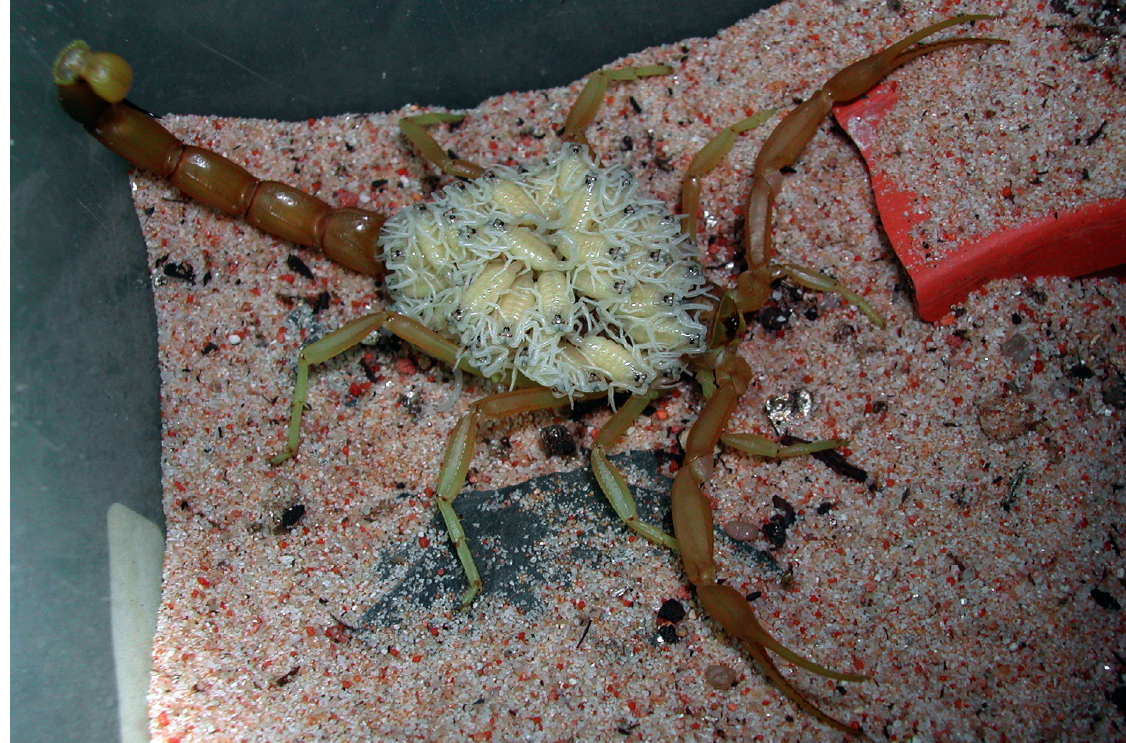
Figure 2. Female of Leiurus quinquestriatus in captivity carrying first-instar juveniles. According to Thornton [33] brood size can globally vary from 40 to 60 (copyright by E. Ythier, reproduced with